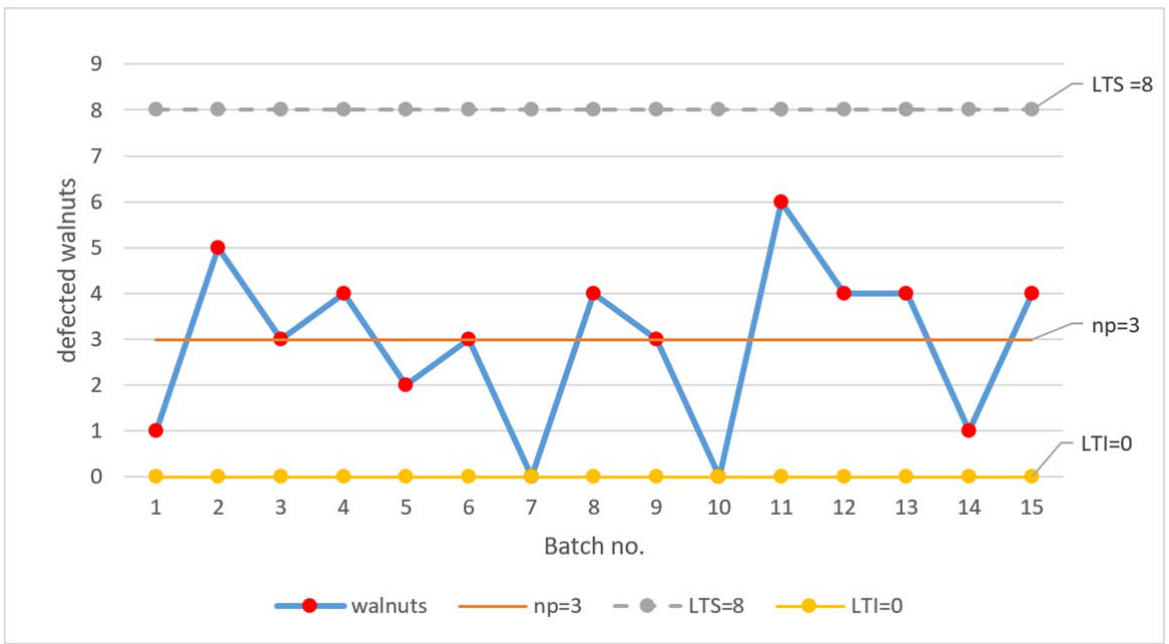
Figure 2. Graphic representation of nP - chart. Variation of the number of damaged walnuts in the tested